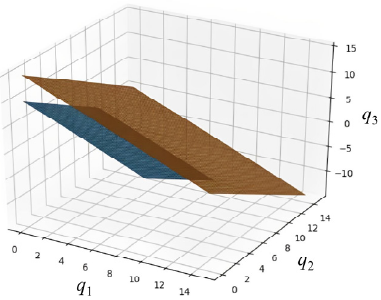
Figure 6. Three − dimensional indifference curve of the perfect substitution utility